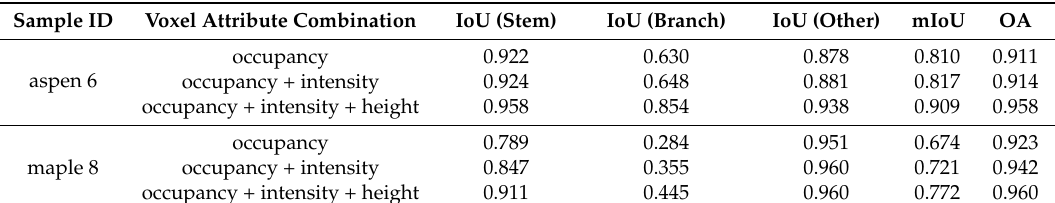
Table 4. Effect of voxel attribution on 3-D FCN filtering accuracies (per-class IoU, mIoU, and OA) at the 25,000th iteration.